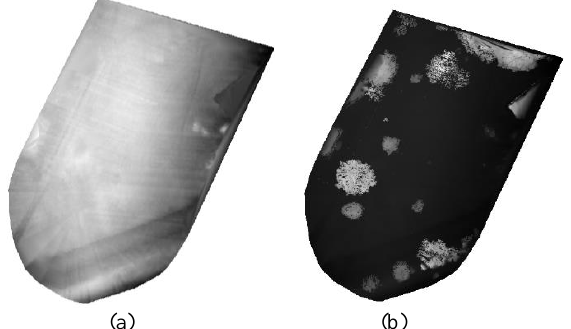
Figure 3. Digital Terrain Model and Digital Surface Model used for CHM generation.